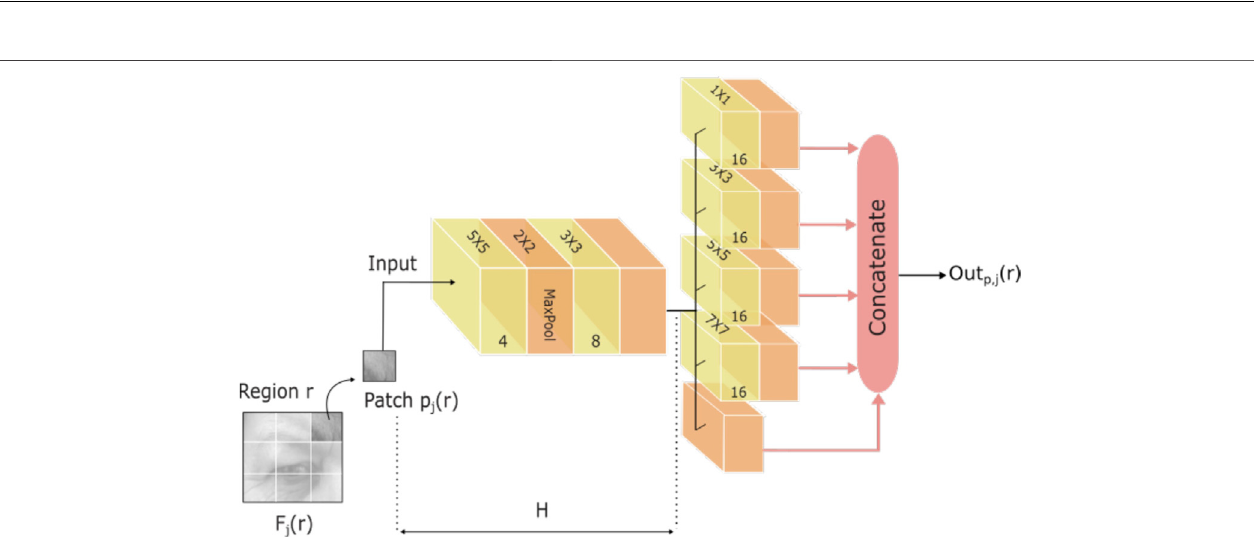
FIGURE3| Theproposedmodelforspatialfeaturesextractionfromtheleft\{eye+eyebrow\}region.Themodelcontainstwomainparts:theextractionoffeatures from patch P j ( r ) using CNN and the fusion of features using SE. Image reproduced from the SAMM database with permission from Davison A. K et al. (2018).